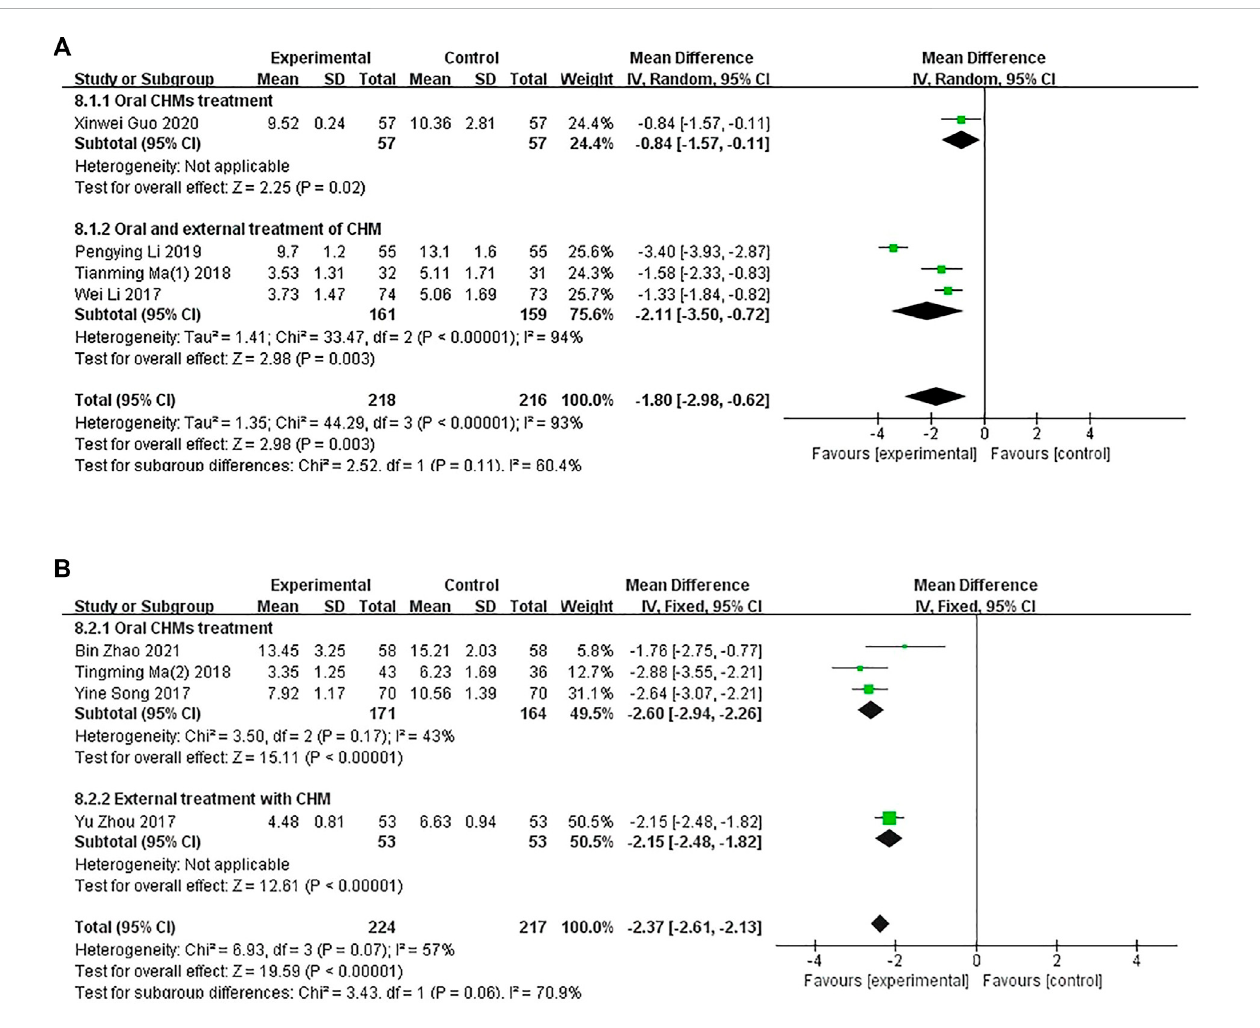
FIGURE 7 The results of the meta-analysis for the effect of Chinese herbal medicine or a combination of CHM and Western medicine (WM) versus WM on the Dermatology Life Quality Index score. (A) CHM versus WM; (B) Combination of CHM and WM versus WM.